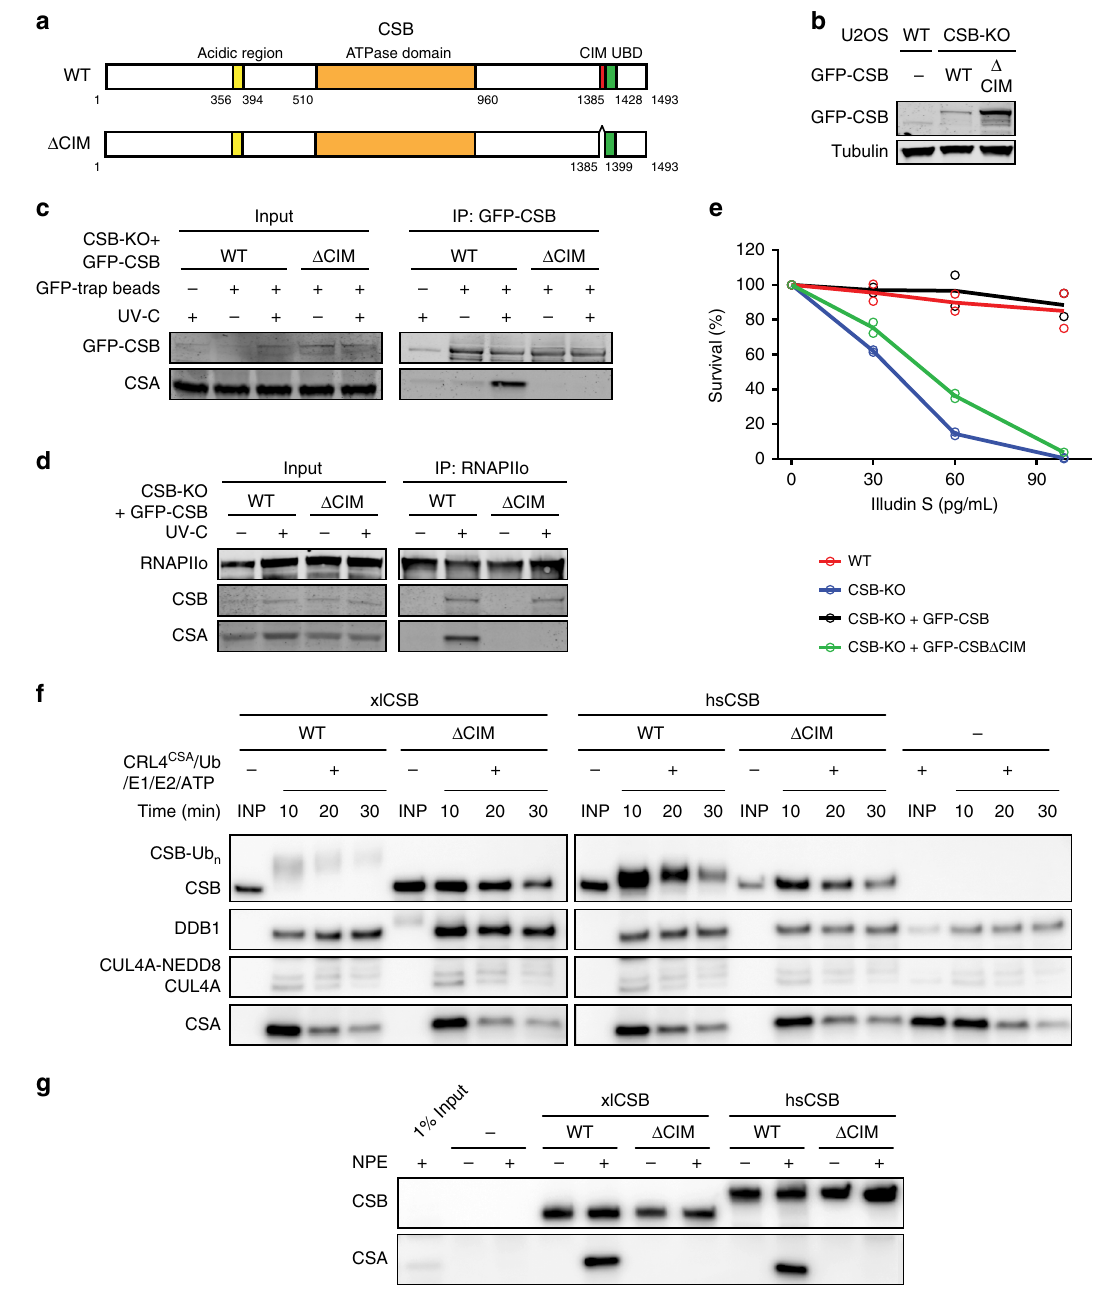
Fig. 3 The CIM of CSB mediates the recruitment of CSA to DNA damage-stalled RNAPIIo. a A schematic representation of CSB and the CSB Δ CIM mutant. b Western blot analysis of U2OS (FRT) and CSB-KO complemented with either GFP-CSB WT or GFP-CSB Δ CIM ( n = 2). c Co-IP of GFP-CSB WT and GFP- CSB Δ CIM on the combined soluble and chromatin fraction. d Endogenous RNAPII Co-IP in GFP-CSB WT and GFP-CSB Δ CIM cell lines. See also Supplementary Fig. 6e for additional Co-IP data. e Clonogenic Illudin S survival of WT and CSB-KO cell lines and the GFP-tagged CSB rescue cell lines. Each symbol represents the mean of an independent experiment ( n = 2), each of which is based on two technical replicates. Note that the same survival data for WT, CSB-KO and CSB-KO + GFP-CSB is also shown in Fig. 1e. f In vitro ubiquitylation of recombinant Xenopus laevis (xl) and Homo sapiens (hs) CSB variants with recombinant xlCRL4 CSA , E1, E2, ubiquitin, and ATP. At indicated times, in vitro ubiquitylation reactions were stopped and blotted with anti-FLAG (top three panels) or anti-xlCSA (bottom panel) antibodies. See also Supplementary Fig. 6d. g Immobilized recombinant CSB variants were incubated with Xenopus laevis nucleoplasmic extract (NPE), recovered, and blotted with anti-FLAG (top panel) or anti-xlCSA (bottom panel) antibody. At least two independent replicates of each IP and in vitro ubiquitylation experiment were performed obtaining similar results. Source data are provided as a Source Data fi